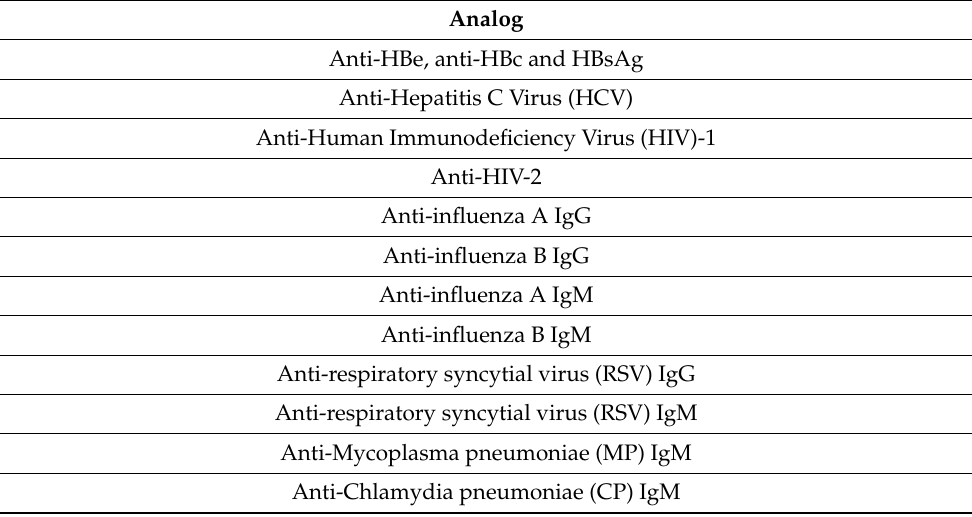
Table 1. Common infectious agents used in cross-reactivity